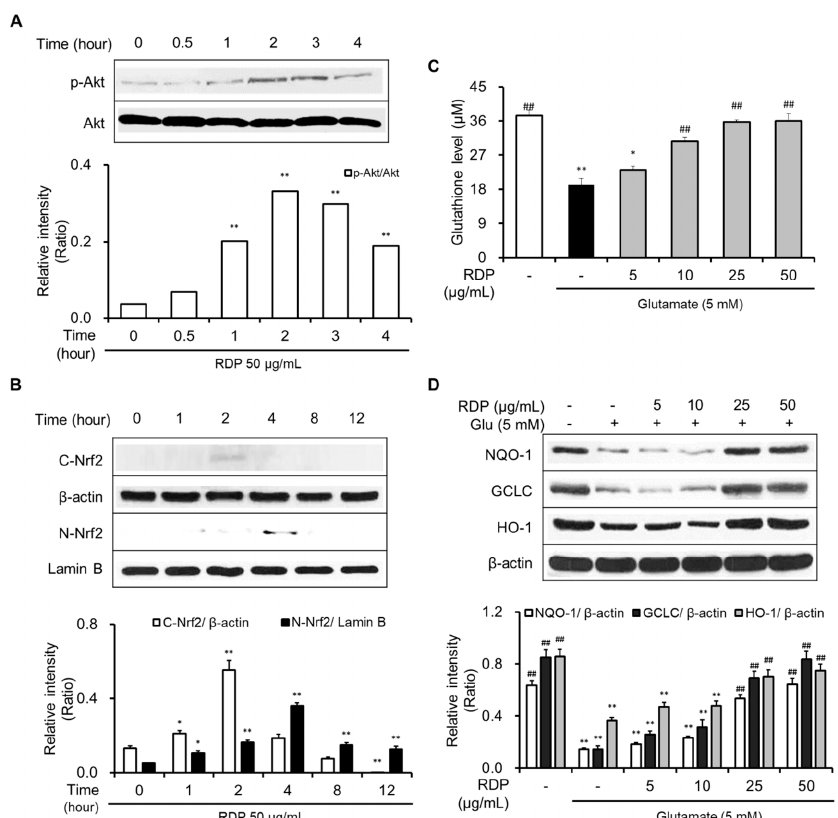
Figure 6. Activation of the Akt / Nrf2 / ARE pathway in HT-22 cells by ethyl acetate extract of Ribes diacanthum Pall (RDP). The experiments were performed as elaborated in the Materials and Methods. The data were obtained from three independent experiments. ( A ) p-Akt, ( B ) cytosolic and nuclear Nrf2, ( C ) glutathione, and ( D ) NQO-1, GCLC, and HO-1. * p < 0.05, and ** p < 0.01 versus vehicle control group. ## p < 0.01 versus glutamate-treated group–indicates absence, + indicates presence. Antioxidants 2020 , 9 , x FOR PEER REVIEW